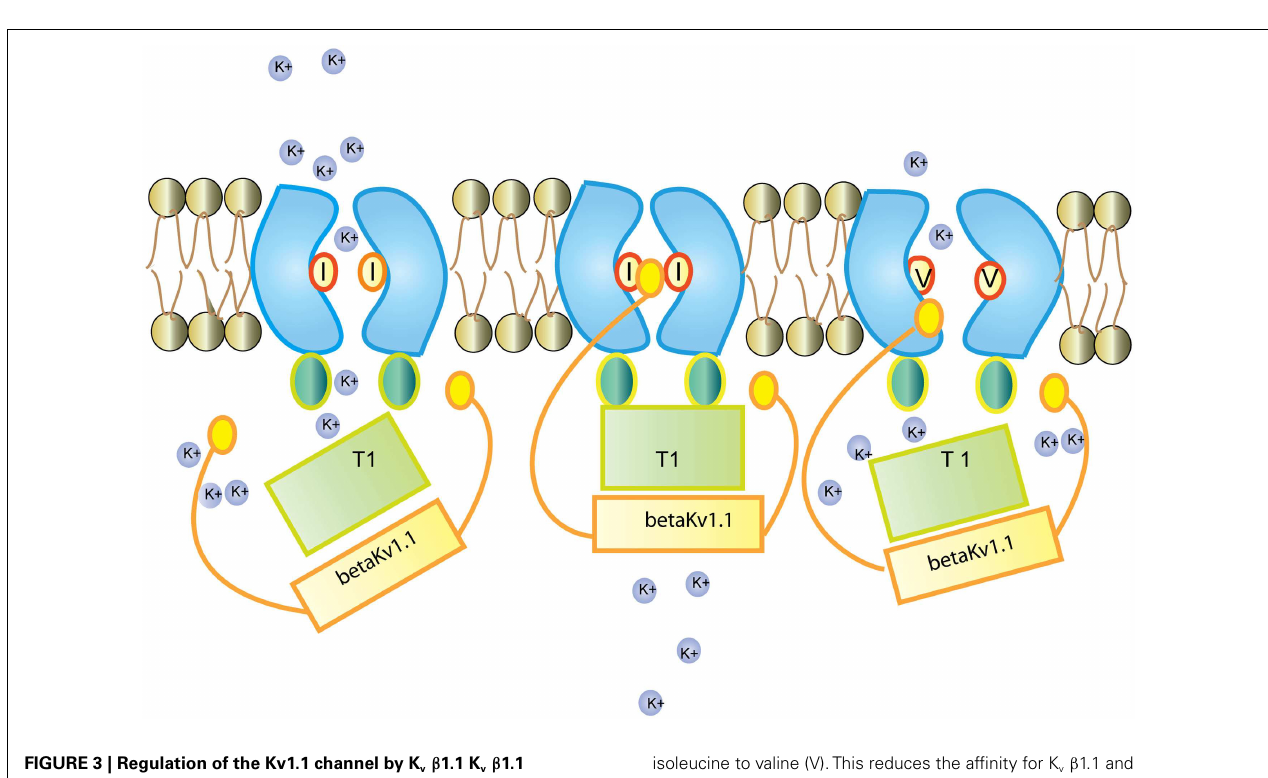
FIGURE 3 | Regulation of the Kv1.1 channel by K v β 1.1 K v β 1.1 has an inactivation gate which interacts with the unedited